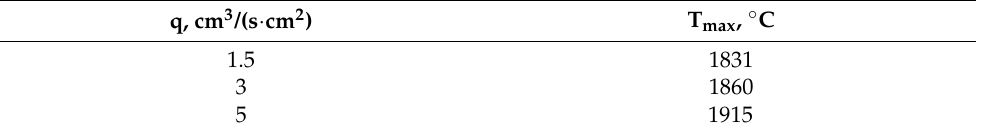
Figure 5. Heat patterns obtained during the combustion of the (70% AlN+ 30% Al) sample in nitrogen. The maximum combustion temperature of the initial composition depending on the specific flow rate of nitrogen is shown in Table 2. Table 2. Maximum combustion temperature of the (70% AlN + 30% Al) sample depending on the specific flow rate of nitrogen.